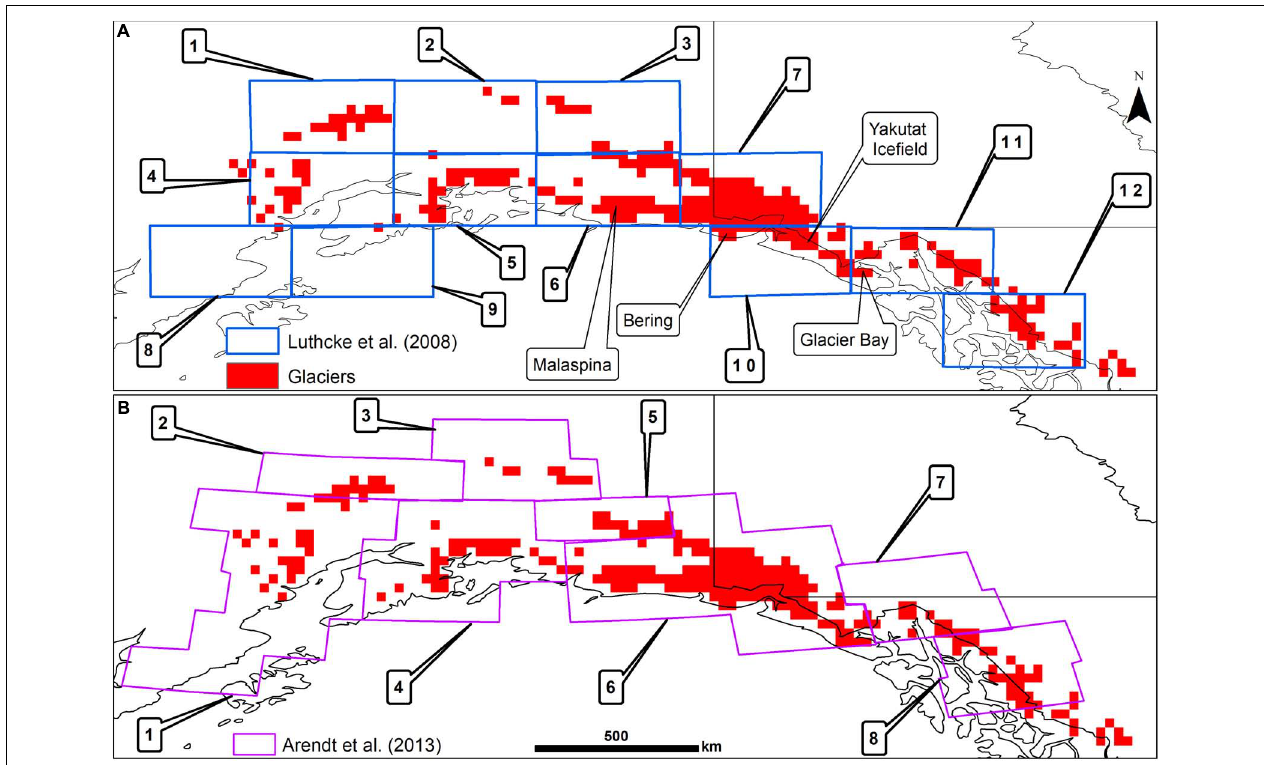
FIGURE 7 | Overlay of mascon delineations from other studies over the glacier distribution map used in this study: (A) delineation used by Luthcke et al. (2008) and (B) delineation used by Arendt et al. (2013), in which Glacier Bay is included in mascon 6, corresponding to the Saint Elias Mountains ( Supplementary Table S2 ).